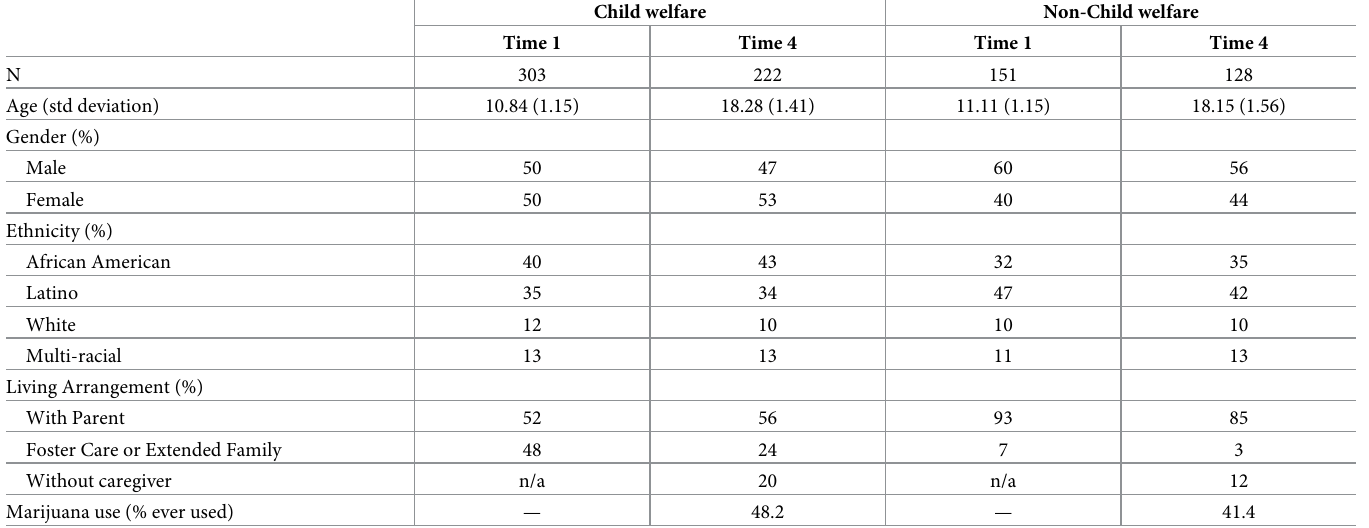
Table 1. Sample characteristics for Time 1 and